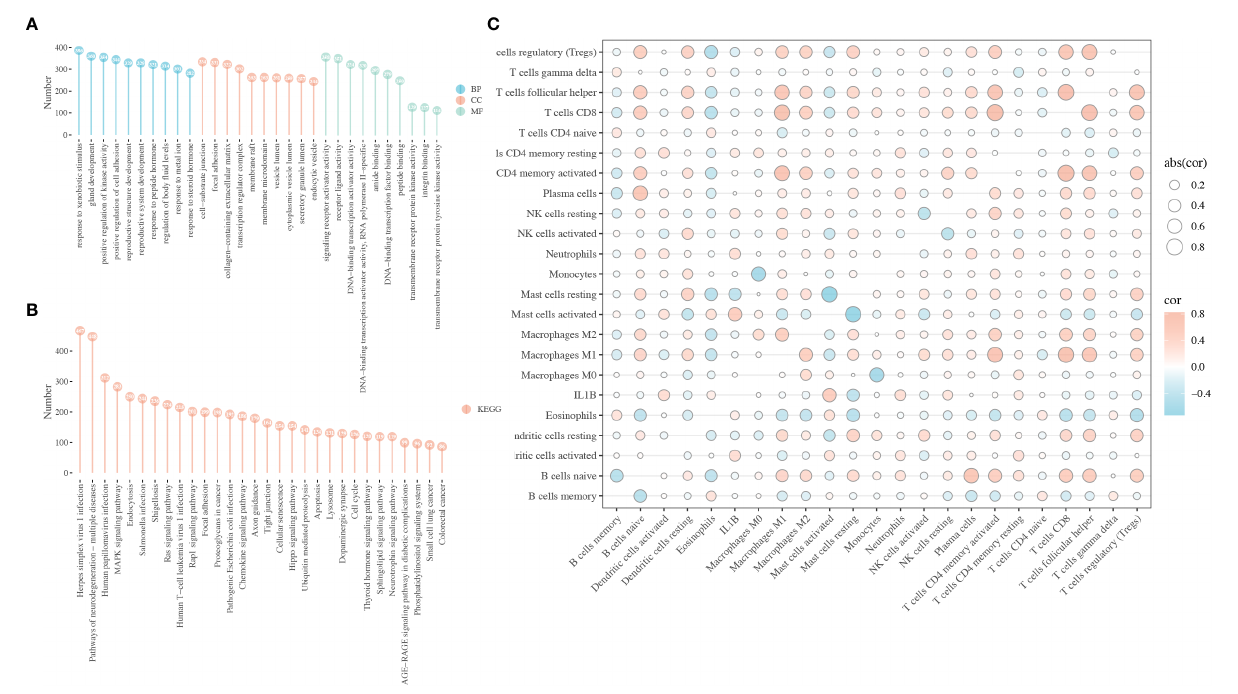
FIGURE 4 Biological function of IL1B in HNSCC. (A) GO enrichment analysis of the DEGs between the IL1B high- and low-expression group, including BP, CC, and MF categories. (B) KEGG analysis of the DEGs between the IL1B high- and low-expression group. (C) The immunocytes in fi ltration and IL1B expression level in HNSCC tissues. GO, Gene oncology; KEGG, Kyoto Encyclopedia of Genes and Genomes; BP, biological process; CC, cellular component; MF, molecular